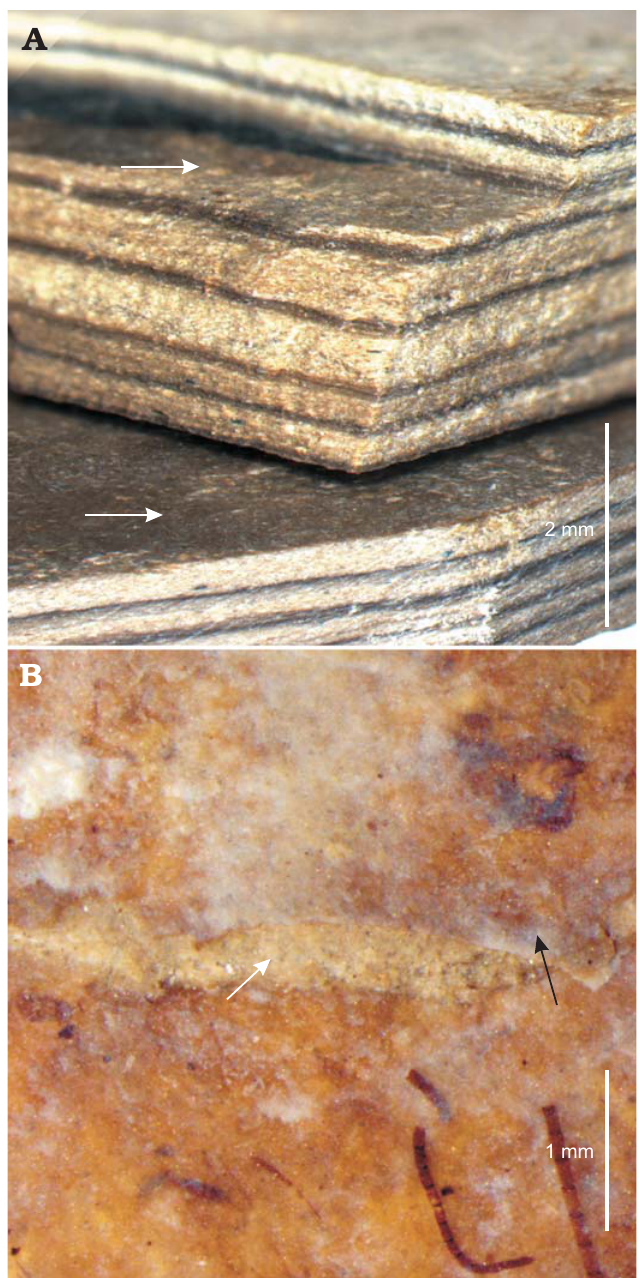
Fig. 11. Splitting of the oil shale from the Coal Creek member of the Kishenehn Formation, Eocene, Montana, USA, exposes the fossil-con- taining microbial mat layer. A . A piece (USNM 560103) that consists of 12 rhythmite couplets. Note that the shale naturally splits (arrows) within the dark microbial mat layer. B . A micrograph of the siliceous surfaces of two rhythmites (USNM 560102). Note the glass-like appearance of the uppermost fossilized mat (black arrow) overlying the thicker clastic basal layer (white arrow). The reddish linear structures at the bottom right of the photograph are fragments of fossil insect antennae on the surface of the mat of the lowermost